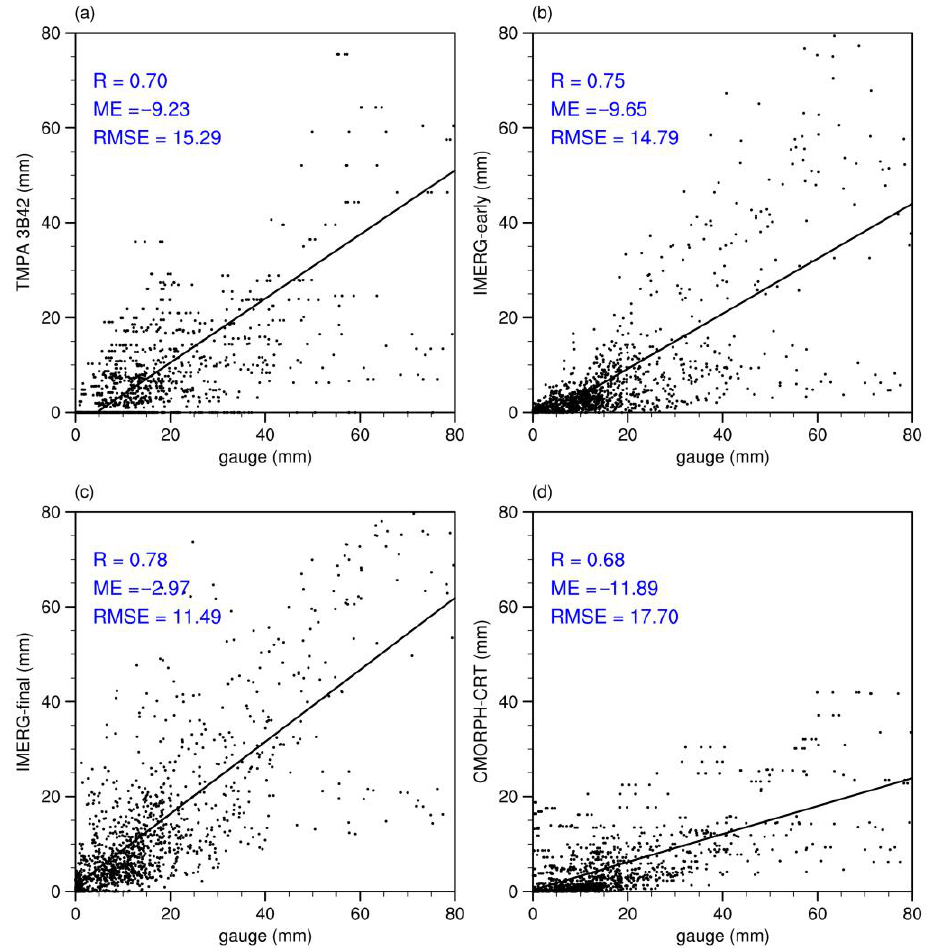
Figure 11. Scatterplots of satellite- and gauge-based accumulated precipitation in Hunan from 25 August 2019 at 00:00 to 27 August 2019 at 00:00. ( a ) TMPA 3B42; ( b ) IMERG-early; ( c ) IMERG-final; and ( d ) CMORPH-CRT.